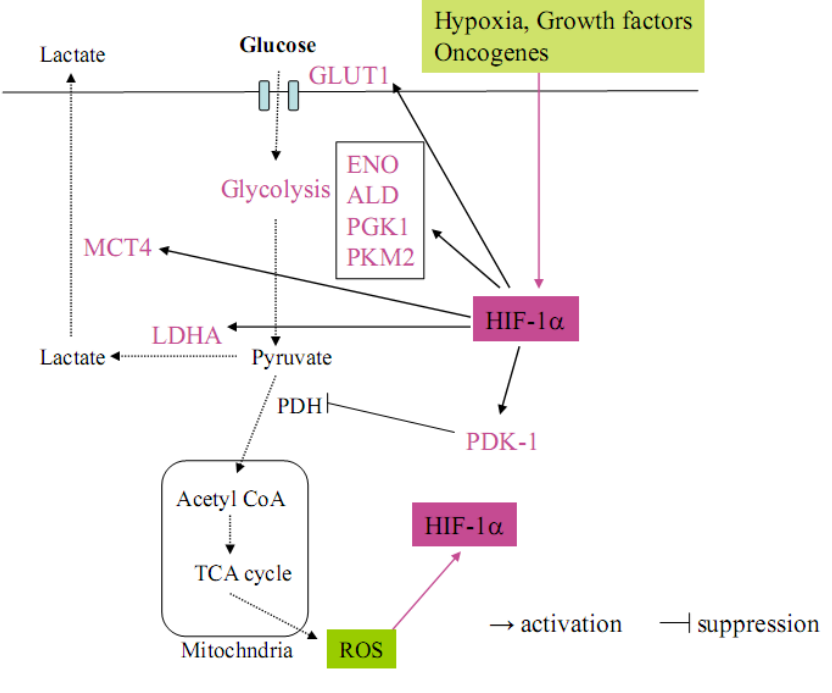
Figure 2. The Warburg effect in cancer cells, in which HIF-1  regulates the target genes related to glucose metabolism. HIF-1  is activated by several factors such as hypoxia, growth factors, oncogenes and intracellular ROS (pink arrow). Activated HIF-1  upregulates glucose transporter GLUT1 to increase the intake of glucose into cancer